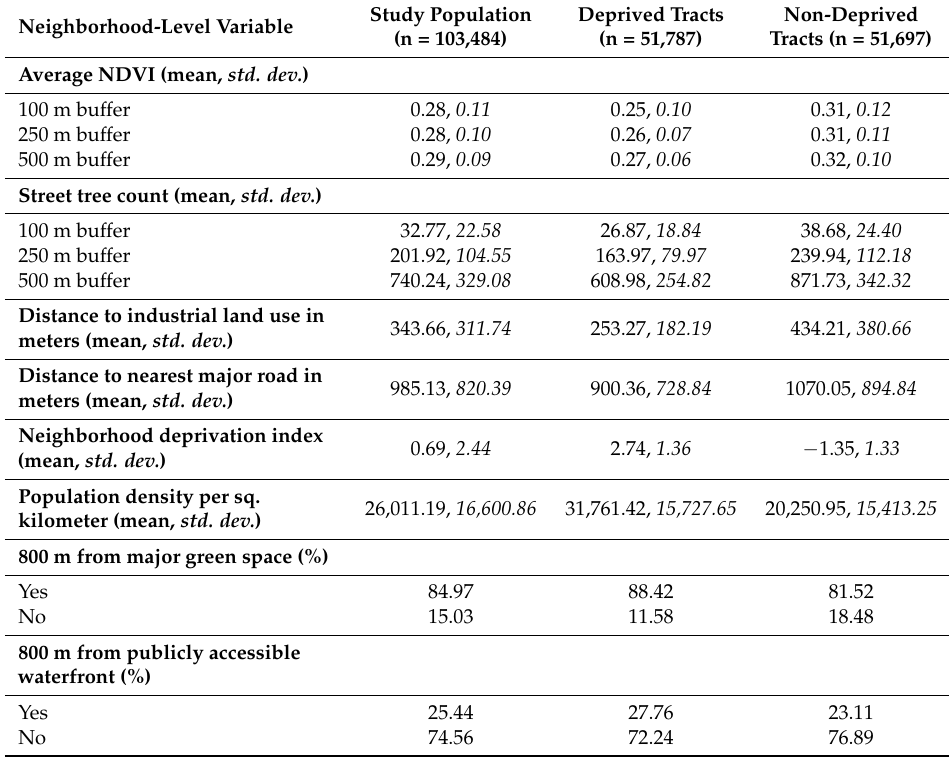
Table 3. Measures of greenness and neighborhood